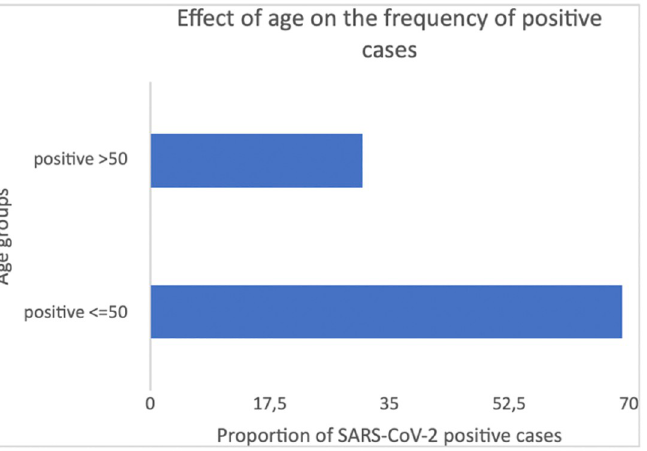
Fig 1. Effects of age on the frequency of positive cases. A total of 69.02% of the individuals who tested positive were of 50 years of age or younger, while 30.98% were > 50 years old, and the chi-square test revealed this association between the proportion of positive cases and two age groups to be significant ( X 2 = 10.274; df = 1; p =